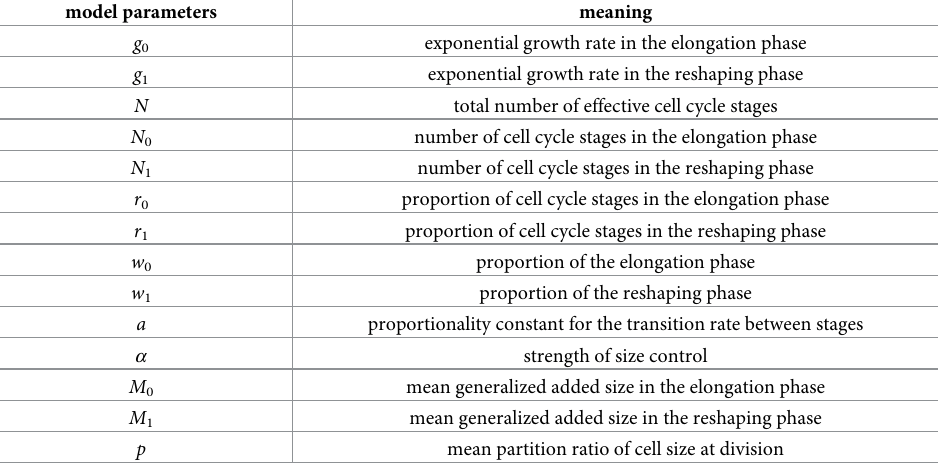
Table 1. Model parameters and their